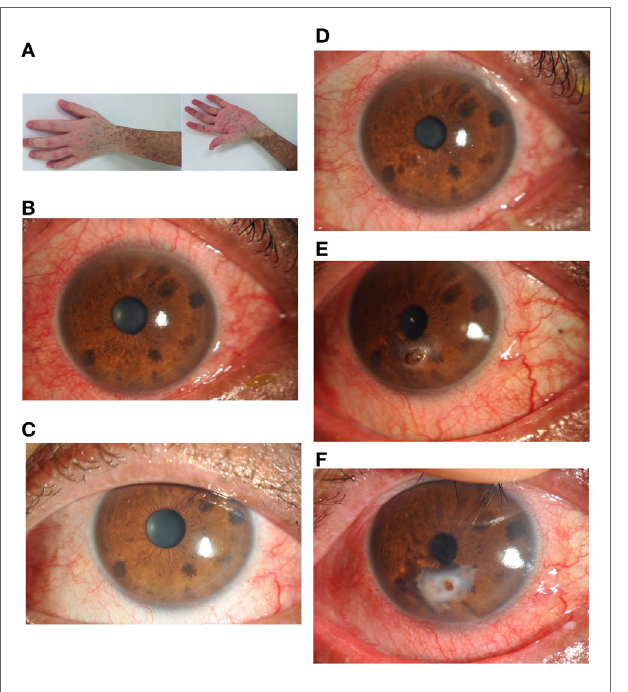
FigUre 1 | a 28-year-old man developed chronic myeloid leukemia in 2003 . He underwent a 9/10 locus HLA-matched allogeneic bone marrow transplant in November 2013 with 0.512 μ g/ml serum vitamin A. He described no ocular symptoms at 3 months after hematopoietic stem cell transplantation with 0.454 μ g/ml serum vitamin A. Six months later, he developed chronic GVHD affecting the skin (a) , oral mucosa, gastrointestinal system, and eyes (b) . Ocular manifestations (c) were managed symptomatically with topical methylcellulose drops with 1.012 μ g/ml serum vitamin A. In October 2014, he developed severe graft-versus-host disease affecting the skin, oral mucosa, liver, lungs, and eyes (D) . Ocular discomfort was managed symptomatically again with topical methylcellulose drops and artificial eye drops. One month later, he was referred to the ophthalmology department with a 2 mm perforation complicating a generalized progressive stromal melt (e) with 0.147 μ g/ml serum vitamin A. Ocular perforation was managed with topical 0.1% flumetholon, 0.3 sodium hyaluronate drops, vitamin A gel, and a corneal bandage lens. The cornea perforation was healed (F) with 3 months treatment. At that time, the patient showed normal liver function and 0.527 μ g/ml serum vitamin A.